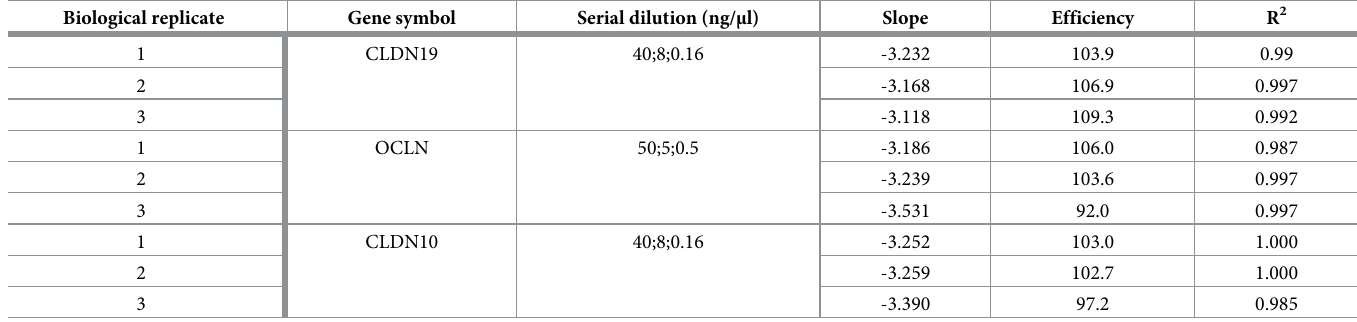
Table 3. Singleplex standardization for caecum